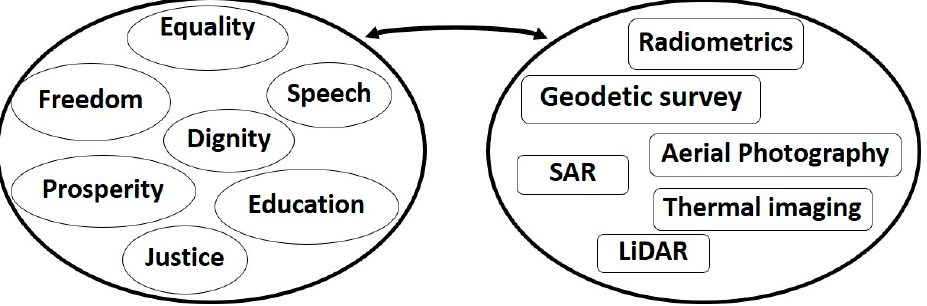
Figure 11. Remote sensing and human rights [15].